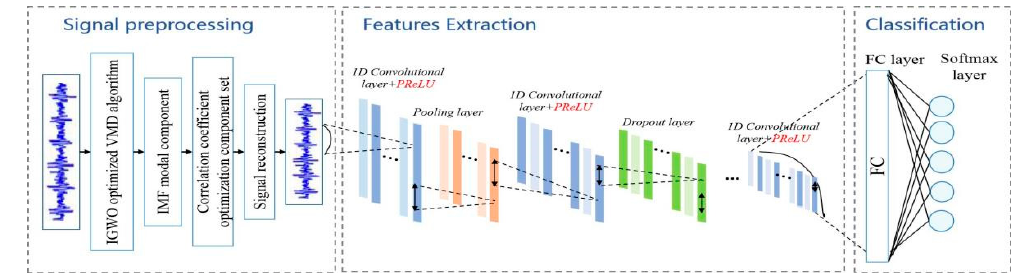
Figure 4. The 1DCNN structure in the experiment.